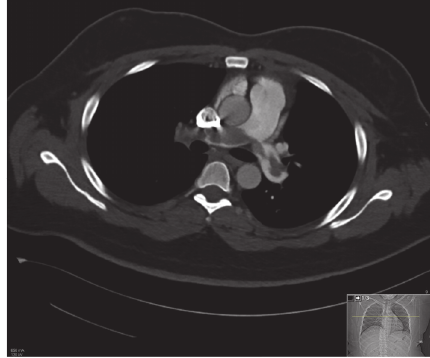
Figure 4: Echocardiogram showing large thrombus in the right